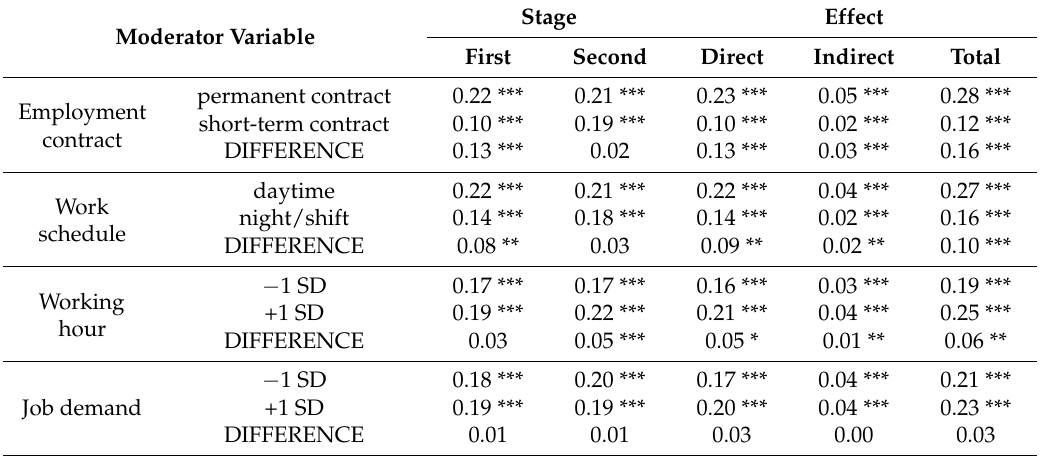
Table 4. Results of the moderated mediation